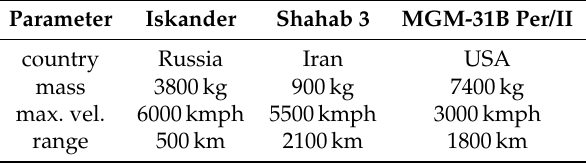
Table 2. Selected parameters of sample interception